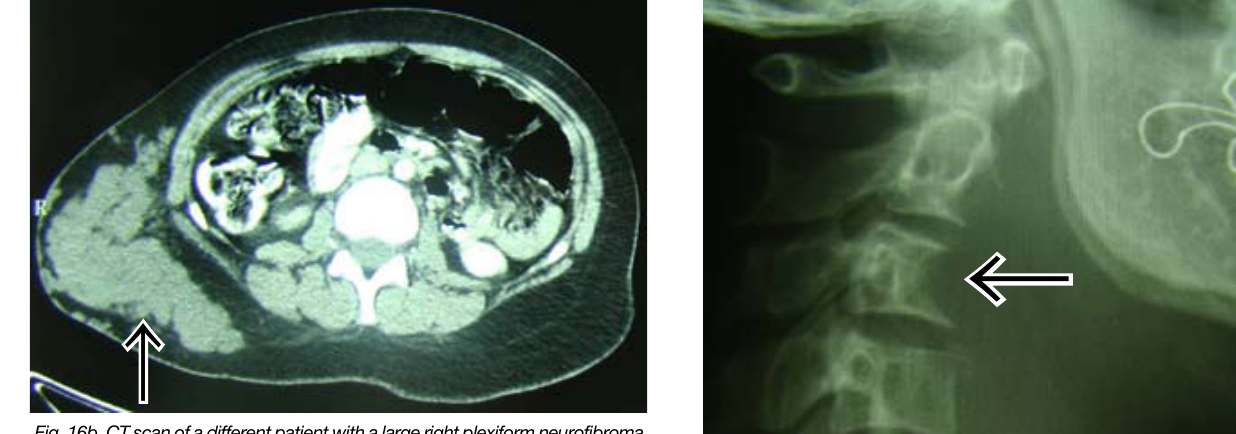
Fig. 16b. CT scan of a different patient with a large right plexiform neurofibroma causing distortion of the abdominal wall.